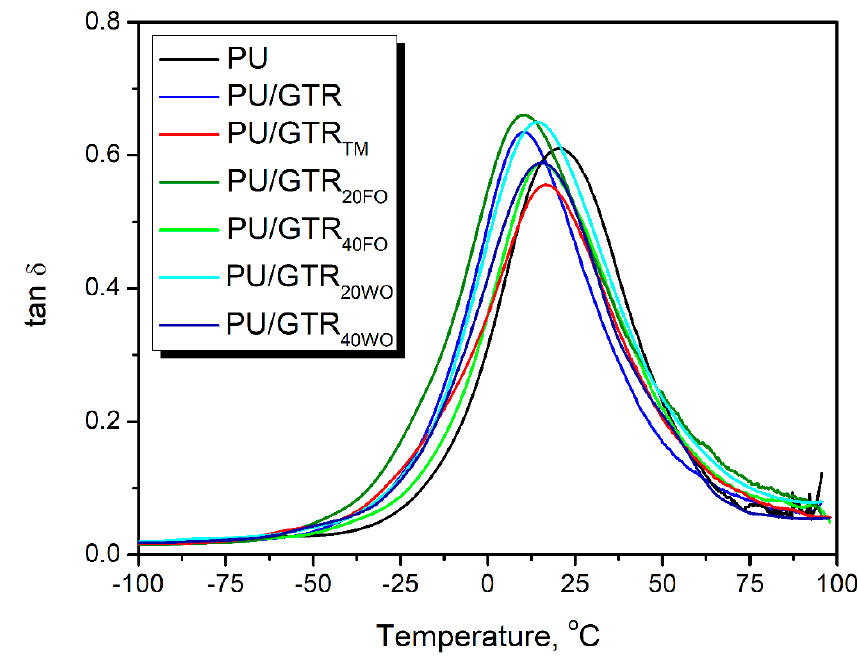
Table 3. The results of static and dynamic mechanical analysis of prepared polyurethane foams. Figure 9. Temperature plot of tan δ for prepared polyurethane foams. Figure 9. Temperature plot of tan δ for prepared polyurethane